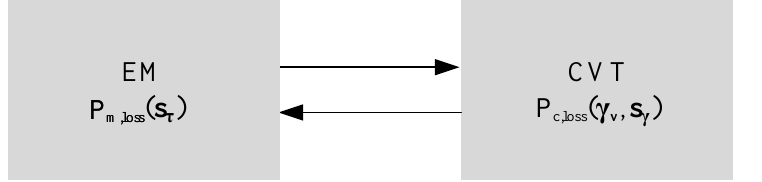
Figure 1. Schematic representation of the coupling between the continuously variable transmission (CVT) and electric machine (EM), where γ v represents the CVT speed ratio, s γ the CVT size, s τ the EM size, P c,loss the CVT power losses, and P m,loss the EM power